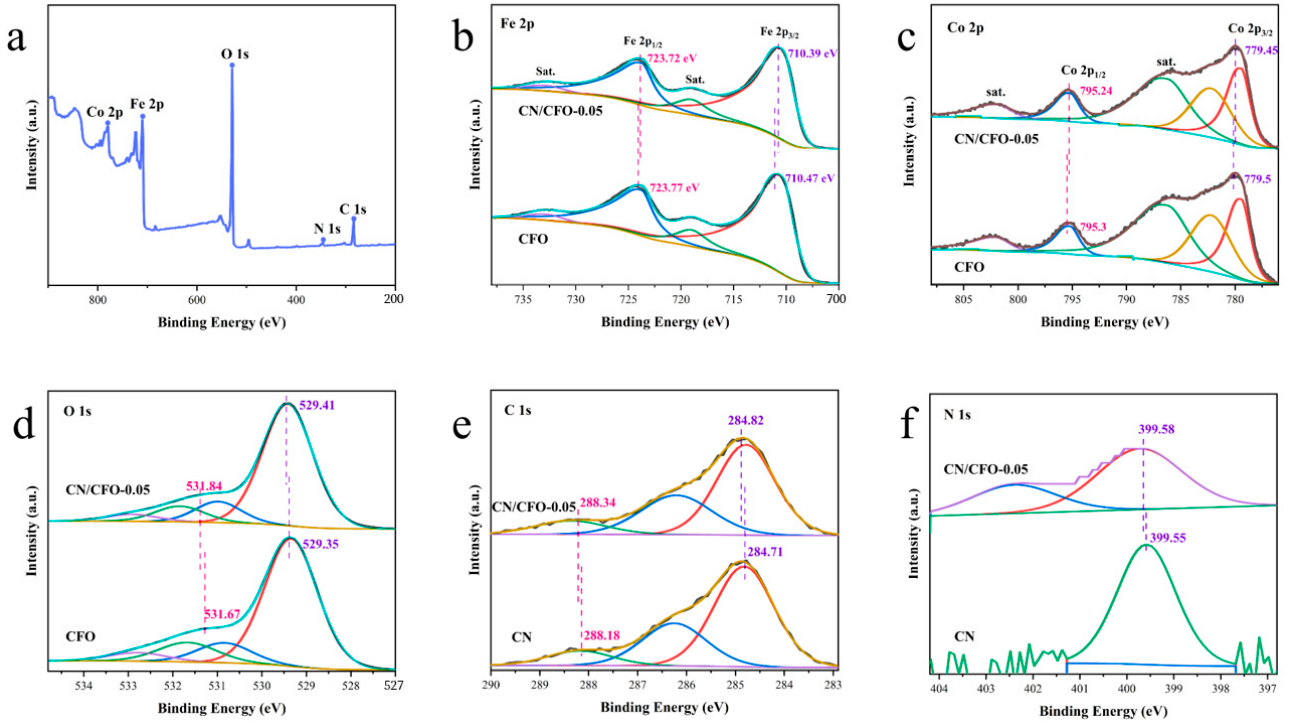
Figure 3. Measured XPS spectrum of CN/CFO-0.05 ( a ); narrow-band Co 2p, Fe 2p, O 1s, C 1s, and N 1s spectra of CFO, CN, and the CN/CFO composites ( b – f ).